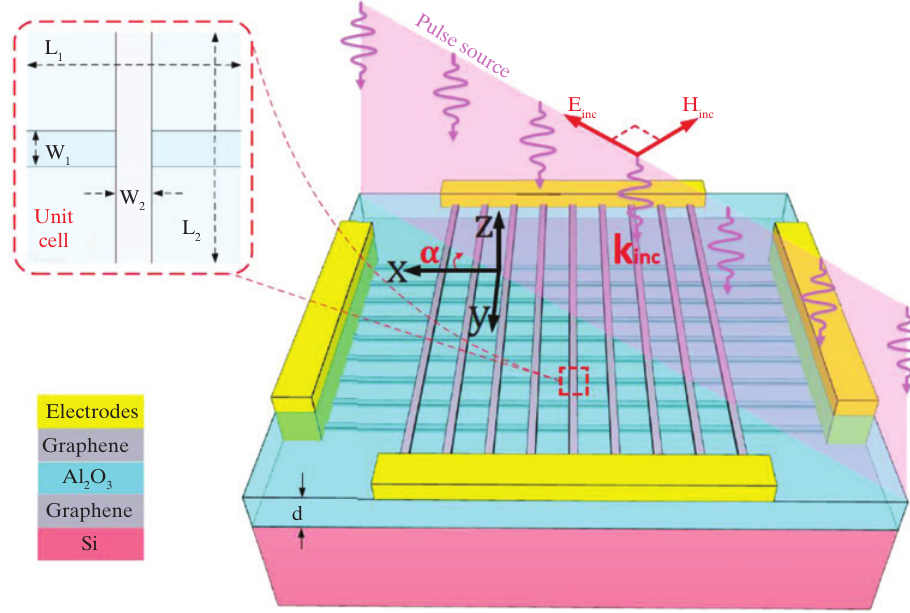
Figure 17: Schematics of a crossed graphene polarizer consisting of two optical gratings made of GNRs separated by a dielectric thin film. The polarization angle of the incident light is α , and the unit cell of this metasurface with periods L widths of GNRs of the top and bottom gratings are W